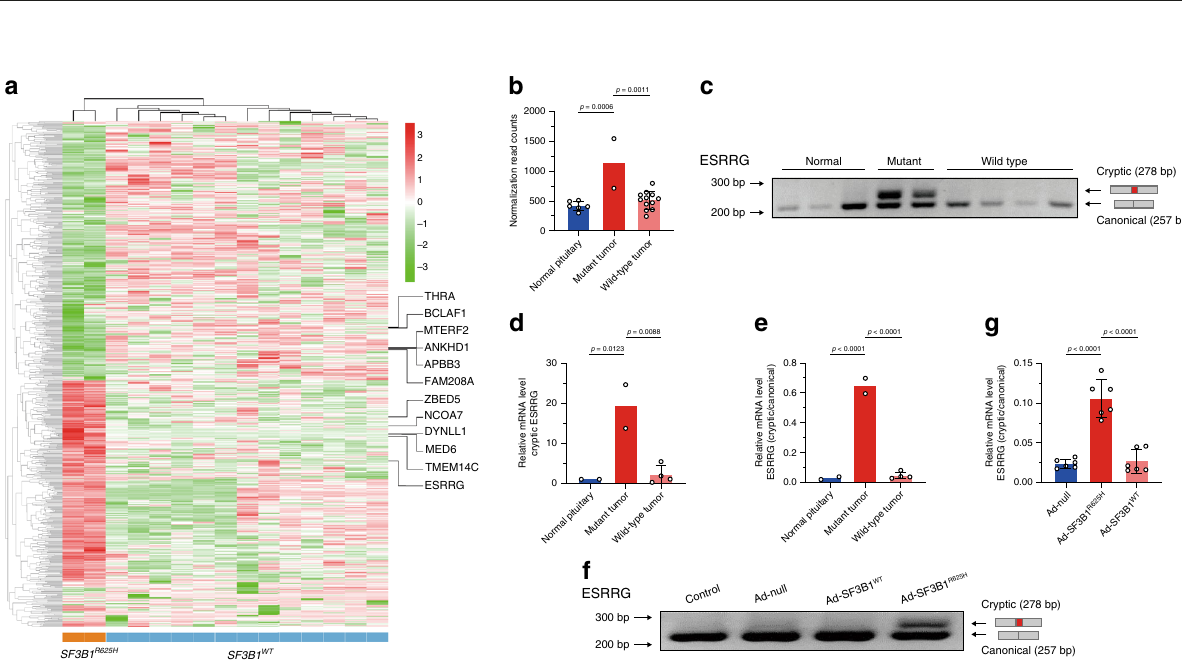
Fig. 3 Aberrant splicing of ESRRG in SF3B1 mutant prolactinoma samples. a Heatmap of SF3B1 R625H -induced splicing alterations in prolactinomas. Rows represent alternative spliced events while columns represent patients. The heatmap matrix values indicate percent spliced in (PSI) value for each individual splicing event to quantify the level of inclusion isoform, which is versus the total abundance of all isoforms, normalized as Z scores. Genes listed on the right side are the A3SS splicing genes veri fi ed by RT-PCR. b The graphs show the ESRRG expression from RNA-seq data in normal pituitaries, prolactinoma samples with mutant and wild type SF3B1 (normal pituitary n = 6, mutant tumor n = 2, and wild-type tumor n = 12). c RT-PCR validation of aberrant splicing of ESRRG in SF3B1 mutant prolactinoma samples. The higher 278 bp band corresponds to the cryptic ESRRG transcript and the lower 257 bp band corresponds to the canonic al ESRRG tr anscript. d The graphs show expression levels of the cryptic ESRRG in normal pituitaries, SF3B1 mutant and SF3B1 wild-type prolactinoma samples (normal pituitary n = 2, mutant tumor n = 2, and wild-type tumor n = 4). e The qRT-PCR graphs show cryptic to canonical isoform ratios in the SF3B1 mutant prolactinoma samples (normal pituitary n = 2, mutant tumor n = 2, and wild-type tumor n = 4). f RT-PCR validation of aberrant splicing of ESRRG in primary human prolactinoma cells infected with Ad-null, Ad-SF3B1 R625H , and Ad-SF3B1 WT respectively. The higher 278 bp band corresponds to the aberrant ESRRG transcript and the lower 257 bp band corresponds to the canonical ESRRG transcript. g The qRT-PCR graphs show cryptic to canonical isoform ratio in primary human prolactinoma cells infected with Ad-null, Ad-SF3B1 R625H , and Ad-SF3B1 WT , respectively ( n = 6 per group). Results are expressed as mean ± SD. The p values by one-way ANOVA followed by Dunnett ’ s multiple comparisons test in b and followed by Tukey ’ s multiple comparisons post hoc test in d , e , g are indicated. Source data are provided as a Source Data fi with the pre-mRNA on the polypyrimidine track 14,15 . RBPmap 16 potentially related to the abnormal splicing of ESRRG (Supple- scan of the U2AF2-binding motif (from CISBP-RNA 17 , id: mentary Fig. 8c). This suggested the impact of SF3B1 R625H on M077_0.6) on the 15 proven alternatively spliced events the splicing of ESRRG through association with the U2 snRNP. demonstrated that all 14 genes had the binding motifs ESRRG belongs to the ESRR family, which is closely associated recognized. ESRRG contained the most binding motifs (3088, with the ER family and has common target genes, co-regulatory signi fi cantly more than others), and over half of the annotated factors, and promoters 18 , whereas ER is an established regulatory factor of PRL synthesis and lactotroph proliferation 19 – 21 and introns ended with the U2AF2-binding motif (Supplementary binds to a single estrogen response element located within the Fig. 8a, b). Interrogation of the location distribution of U2AF2- distal PRL enhancer. binding motif on ESRRG found that the U2 snRNP was